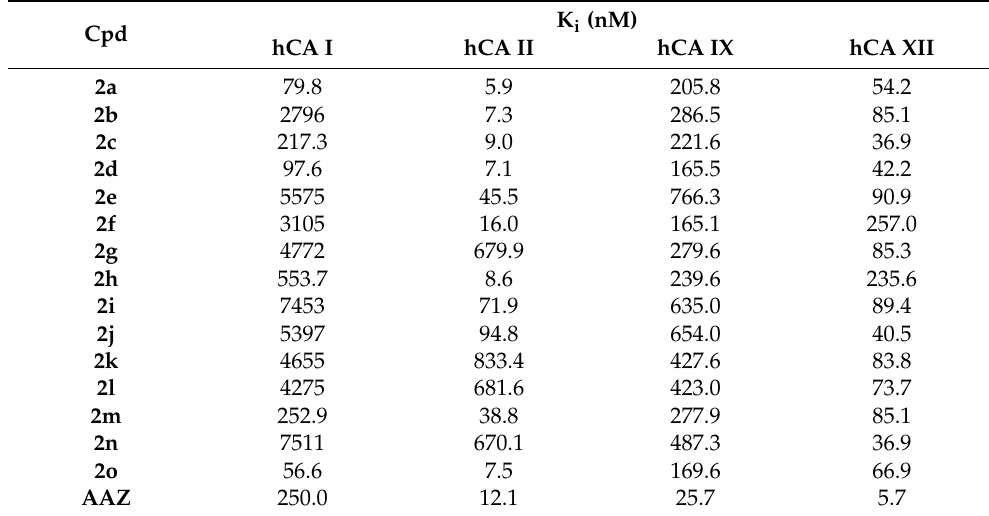
Table 2. Inhibition of hCA isoforms I, II, IX and XII by compounds 2a – o ; acetazolamide (AAZ) was used as a standard inhibitor.